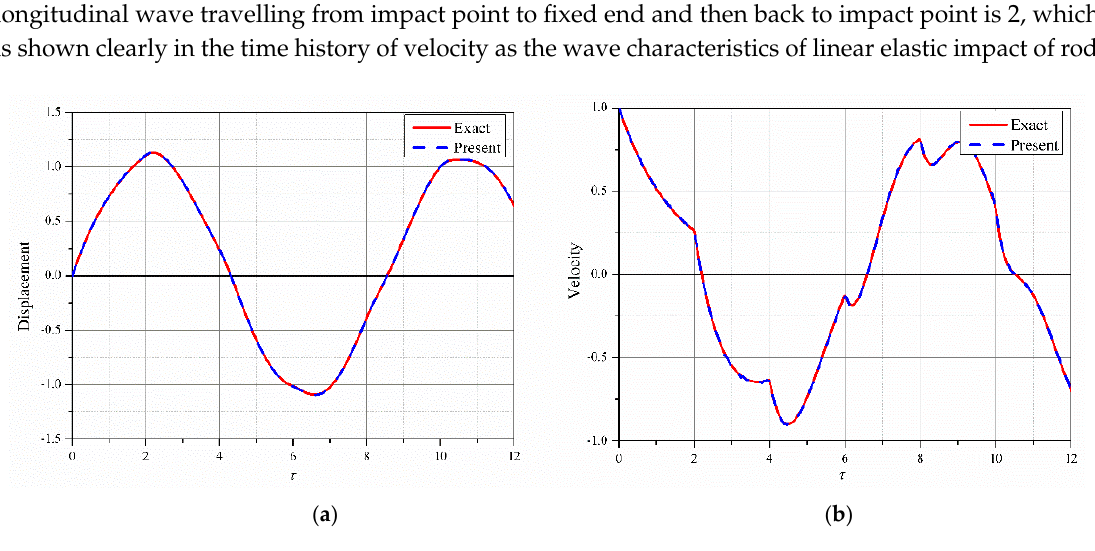
Figure 2. Impact responses of rod. ( a ) Displacements; ( b ) velocities.